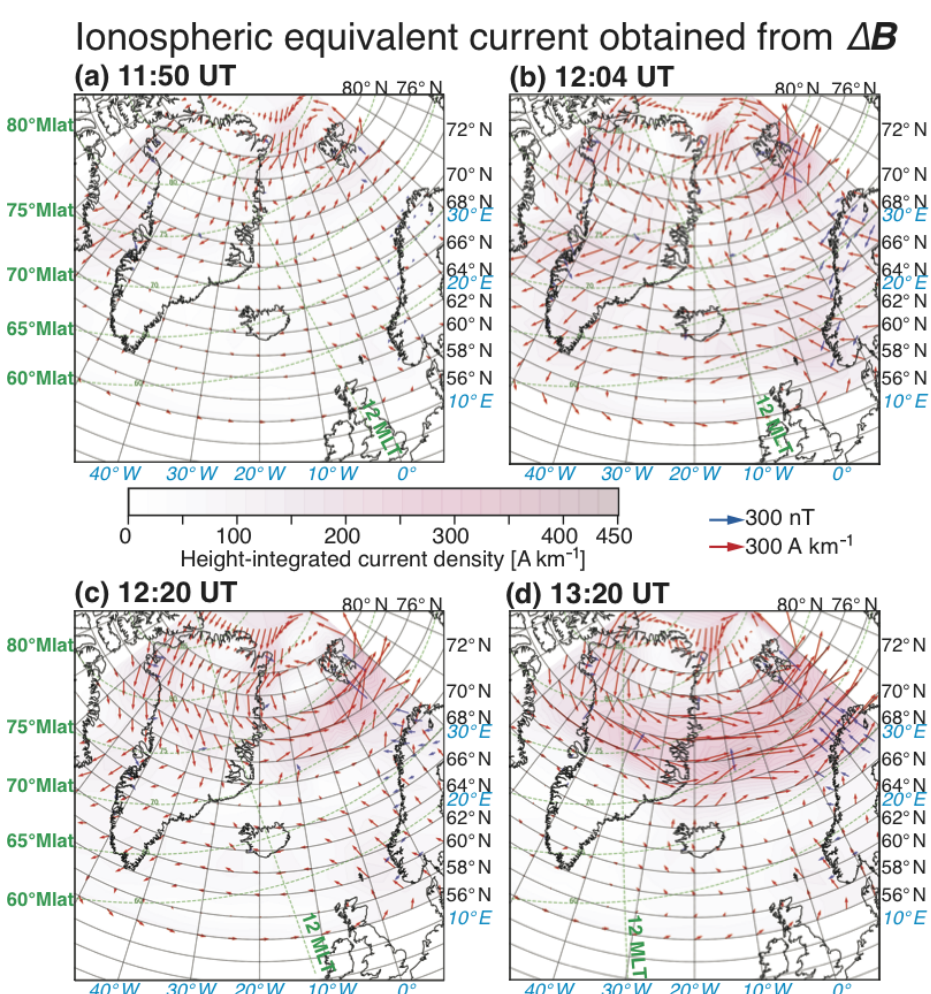
Figure 4. Ionospheric equivalent currents on 6 September 2017, based on magnetometers at Norwegian and Greenland, using the same method as in Fig. 3. (a) Before the flare (11:50UT), (b) the subsolar crochet peak (12:04UT), (c) around the first peak at HOP and BJN (12:20UT), and (d) the main peak at SOR, TRO, and KIR